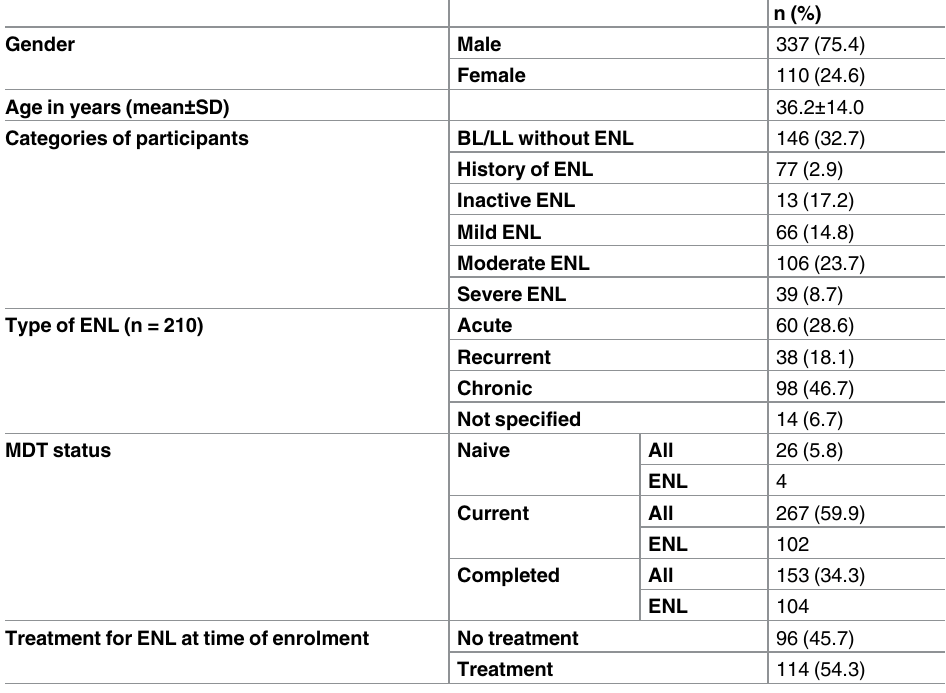
Table 1. Characteristics of the participants in the validation